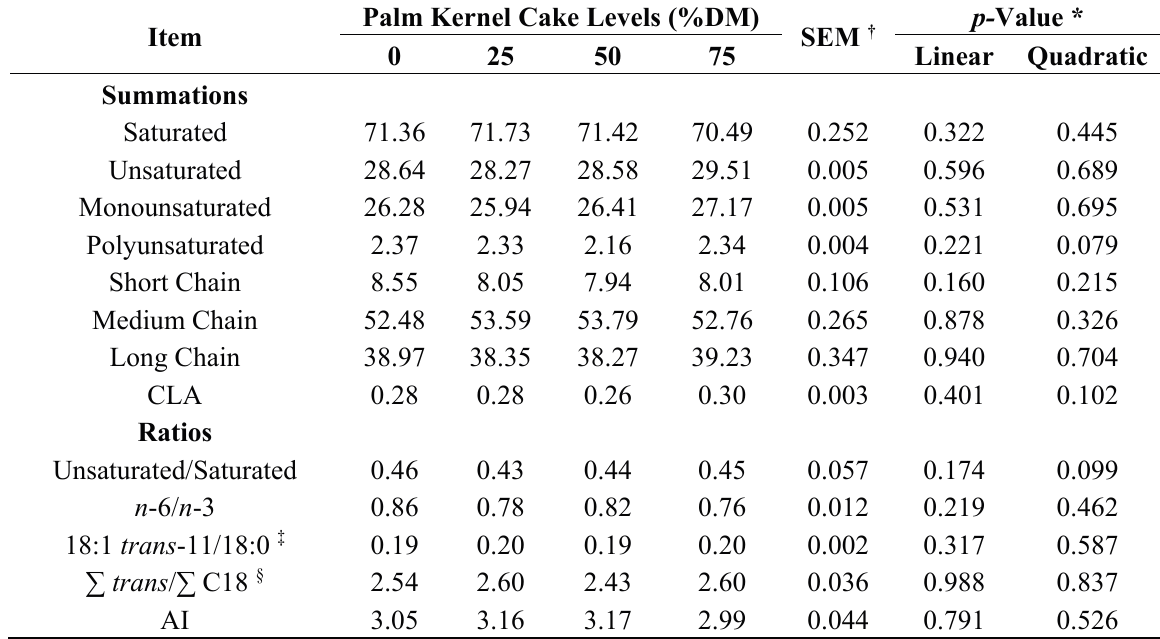
Table 4. The effect of dietary supplementation with differing amounts of palm kernel cake on the grouped fatty acid profile (in g 100 g − 1 of fatty acids) of milk from grazing cows. Item